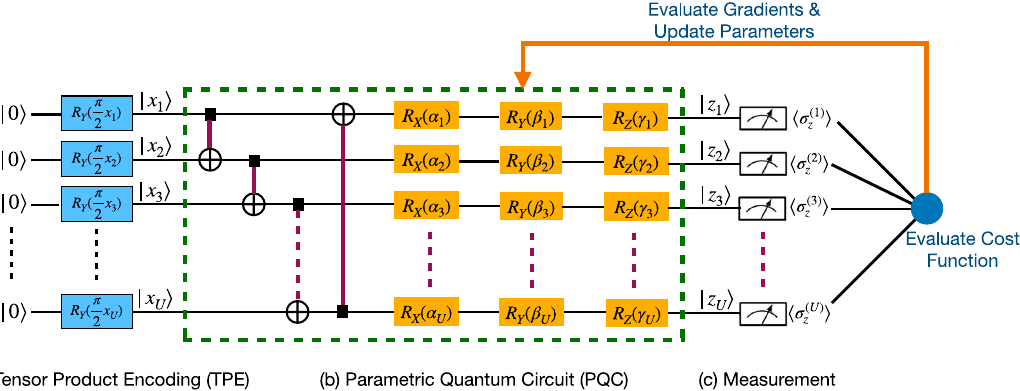
x i Þ to transform classical data into quantum 2